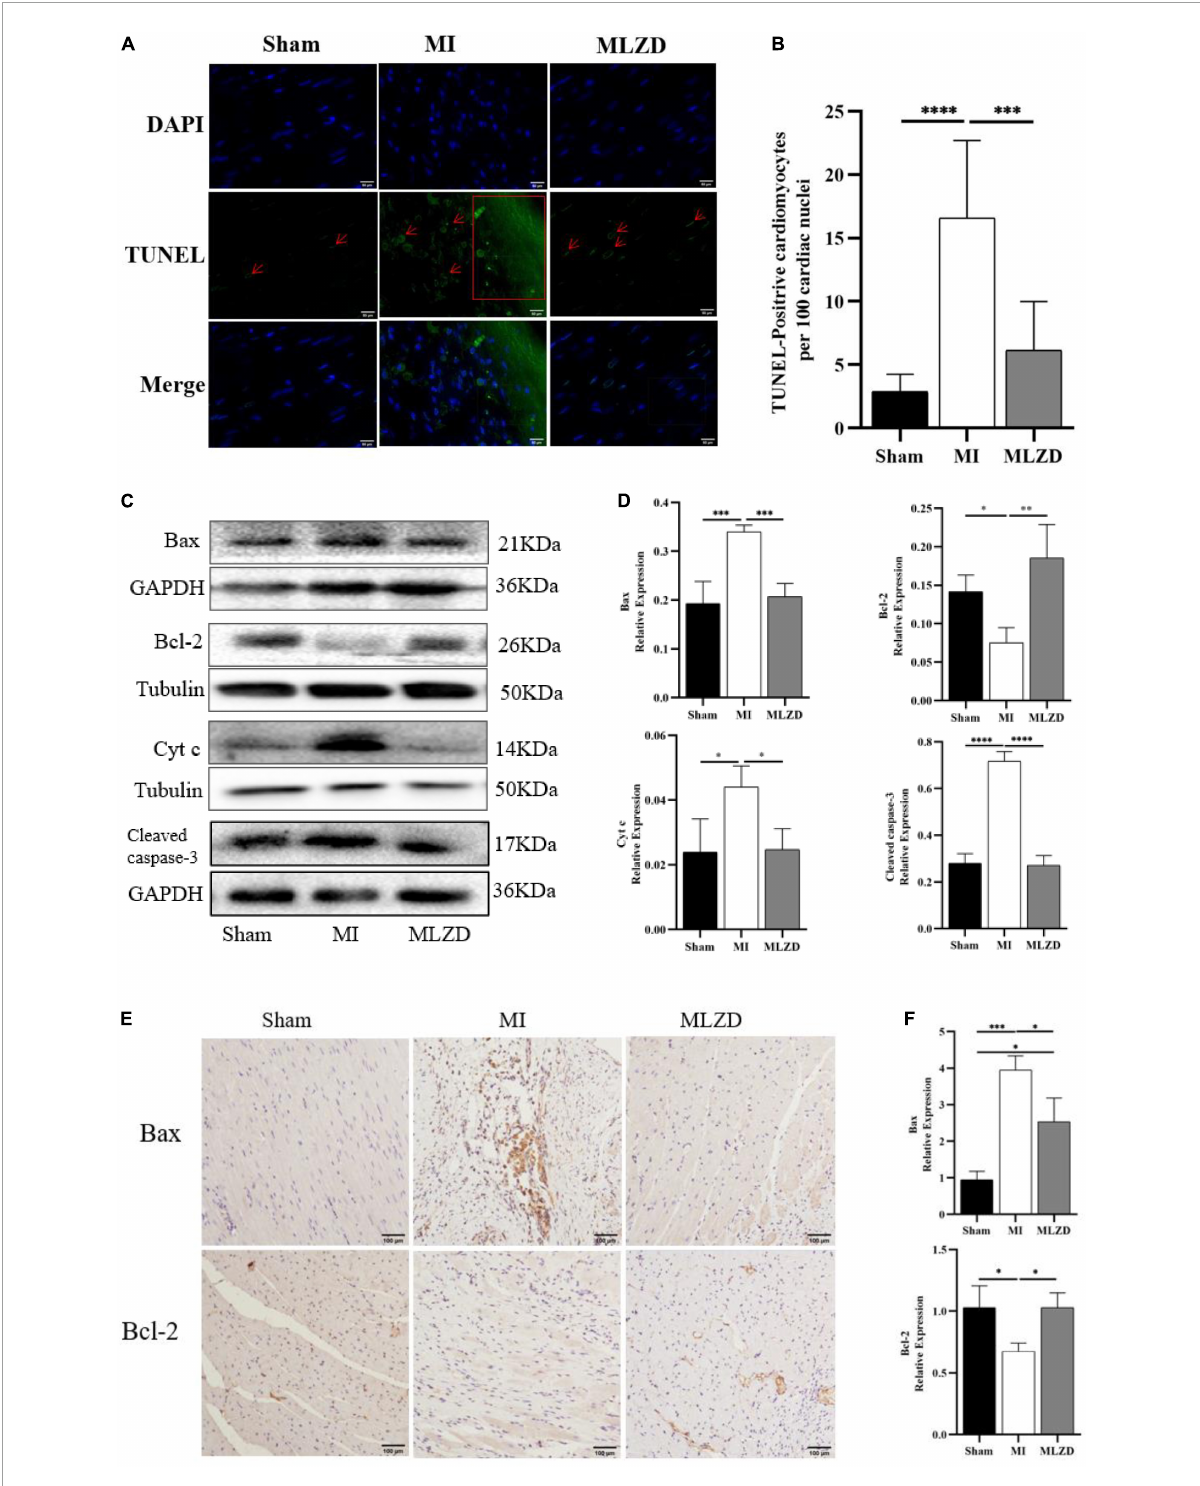
FIGURE4 Modified Linggui Zhugan Decoction (MLZD) ameliorated apoptosis. (A) TUNEL staining for heart tissue, scale bar = 50 µ m. (B) Quantitative analysis for apoptosis, n = 6 or 8 per group. (C,D) Immunoblot analyses of Bax, Bcl-2, Cyt c, and cleaved-caspase-3 in the hearts of different groups. The widths of the images have been compressed at a ratio of 1:0.6. n = 4 or 6 per group. (E,F) Immunohistochemical analyses for detecting Bax and Bcl-2 expression, n = 3 per group, scale bar = 100 µ m. Data are represented as mean ± standard deviation ( x ± s); ∗ P < 0.05, ∗∗ P < 0.01, ∗∗∗ P < 0.001, ∗∗∗∗ P <